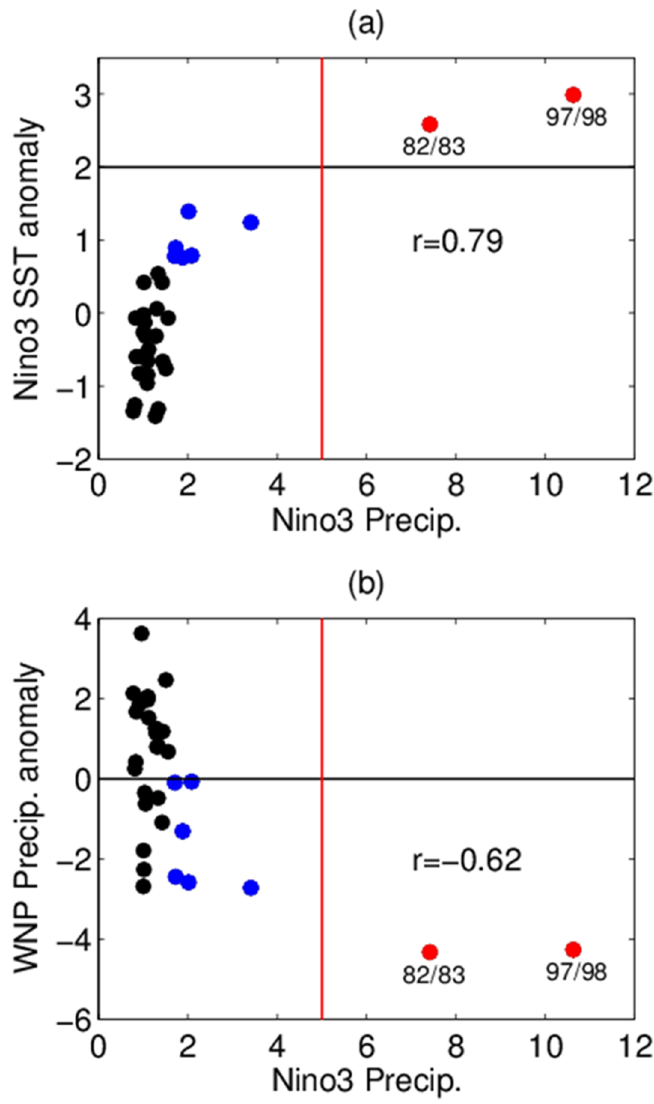
Figure 3. Relationship of Niño3 DJF precipitation (mm/day) with ( a ) detrended Niño3 DJF SST anomalies (°C) and ( b ) DJF precipitation anomalies averaged over the WNP (120° E–140° E, 5° N– 10° N) for 1979–2010. Extreme El Niño, moderate El Niño, and other events are indicated by red, blue, and black dots, respectively.